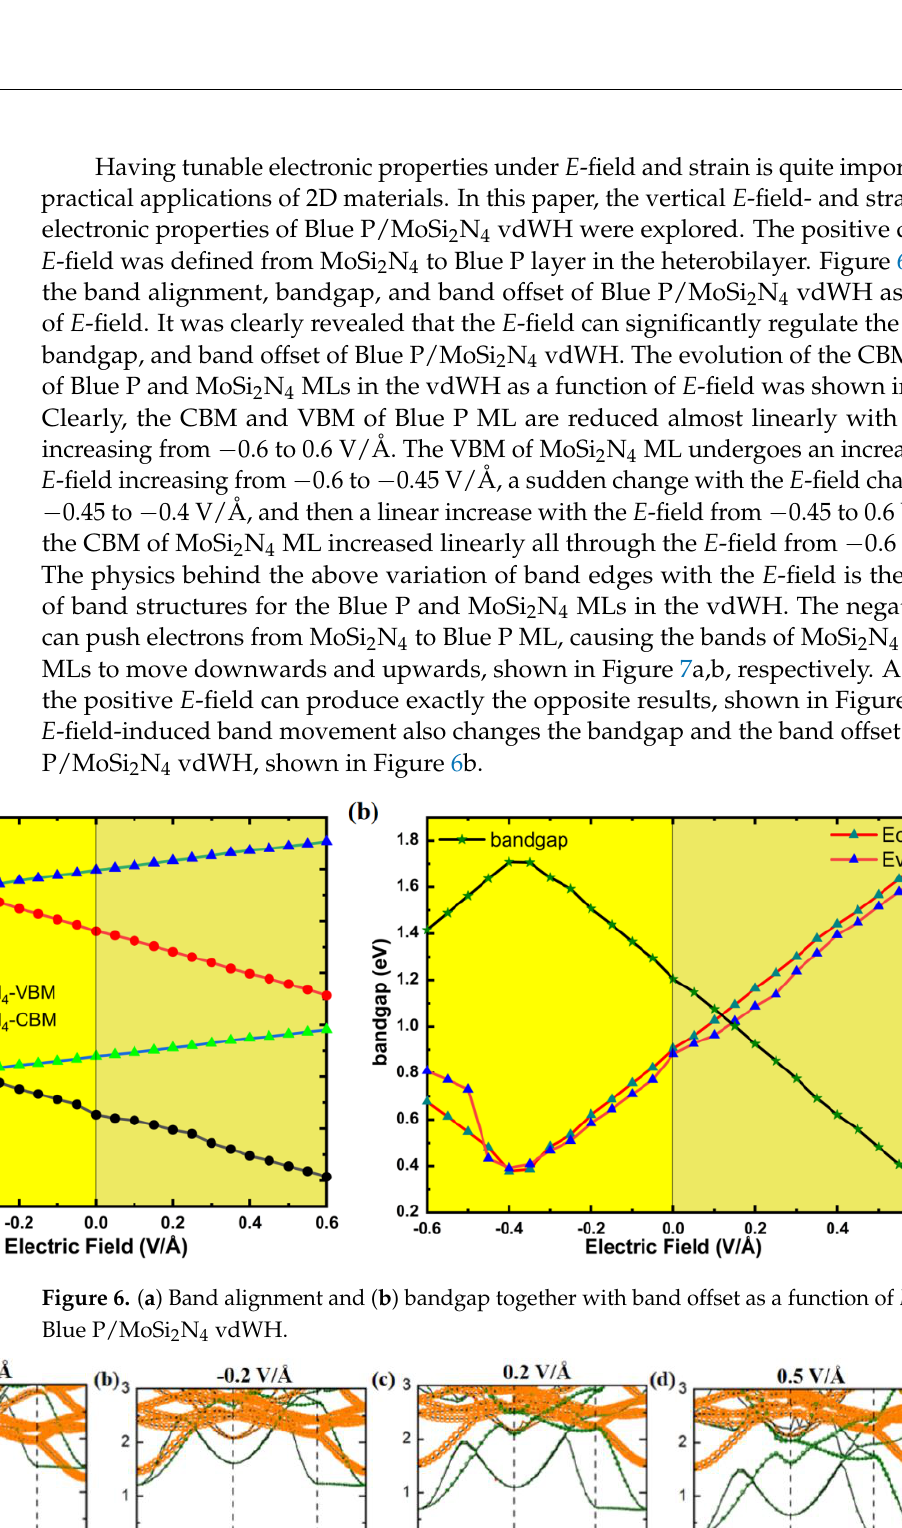
8 of 12 Figure 5. Optical absorption of the Blue P / MoSi 2 N 4 vdWH together with those of isolated Blue P and MoSi 2 N 4 MLs. The visible region is surrounded by blue dashed lines. Having tunable electronic properties under E -field and strain is quite important for the practical applications of 2D materials. In this paper, the vertical E -field- and strain- induced electronic properties of Blue P/MoSi 2 N 4 vdWH were explored. The positive di- rection of E -field was defined from MoSi 2 N 4 to Blue P layer in the heterobilayer. Figure 6 presented the band alignment, bandgap, and band offset of Blue P / MoSi 2 N 4 vdWH as a function of E -field. It was clearly revealed that the E -field can significantly regulate the band edge, bandgap, and band offset of Blue P / MoSi 2 N 4 vdWH. The evolution of the CBM and VBM of Blue P and MoSi 2 N 4 MLs in the vdWH as a function of E -field was shown in Figure 6a. Clearly, the CBM and VBM of Blue P ML are reduced almost linearly with the E -field increasing from −0.6 to 0.6 V/Å. The VBM of MoSi 2 N 4 ML undergoes an increase with the E -field increasing from −0.6 to −0.45 V/Å, a sudden change with the E -field chang- ing from −0.45 to −0.4 V/Å, and then a linear increase with the E -field from −0.45 to 0.6